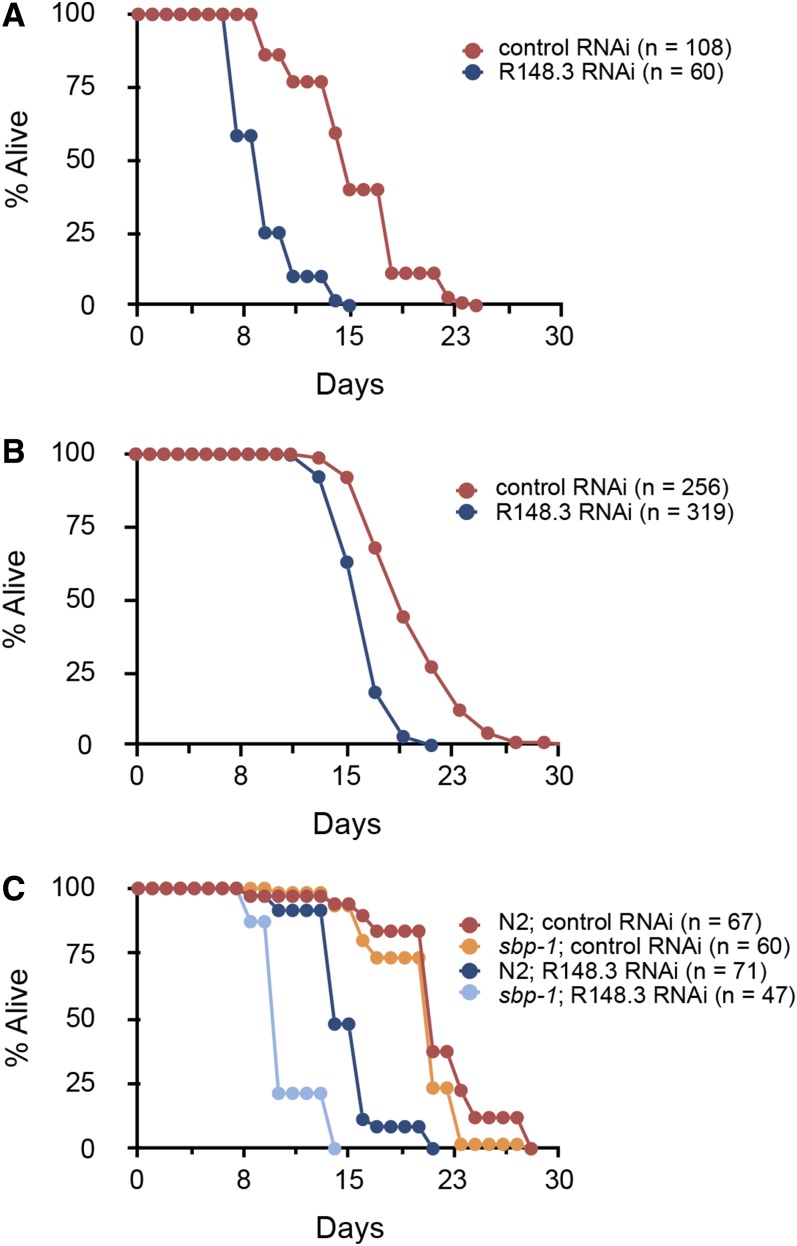
Loss of R148.3 shortens lifespan. Representative population survival curve of (A and B) N2 worms, or (C) sbp-1 mutants fed either empty L4440 vector (control RNAi) or R148.3 RNAi. RNAi was initiated at either (A and C) stage L1 or at (B) stage L4/young adult. For all panels, P < 0.0001 for effects of R148.3 RNAi in all cases. See Tables S3–S5 in File S2 for additional data on replicate experiments.